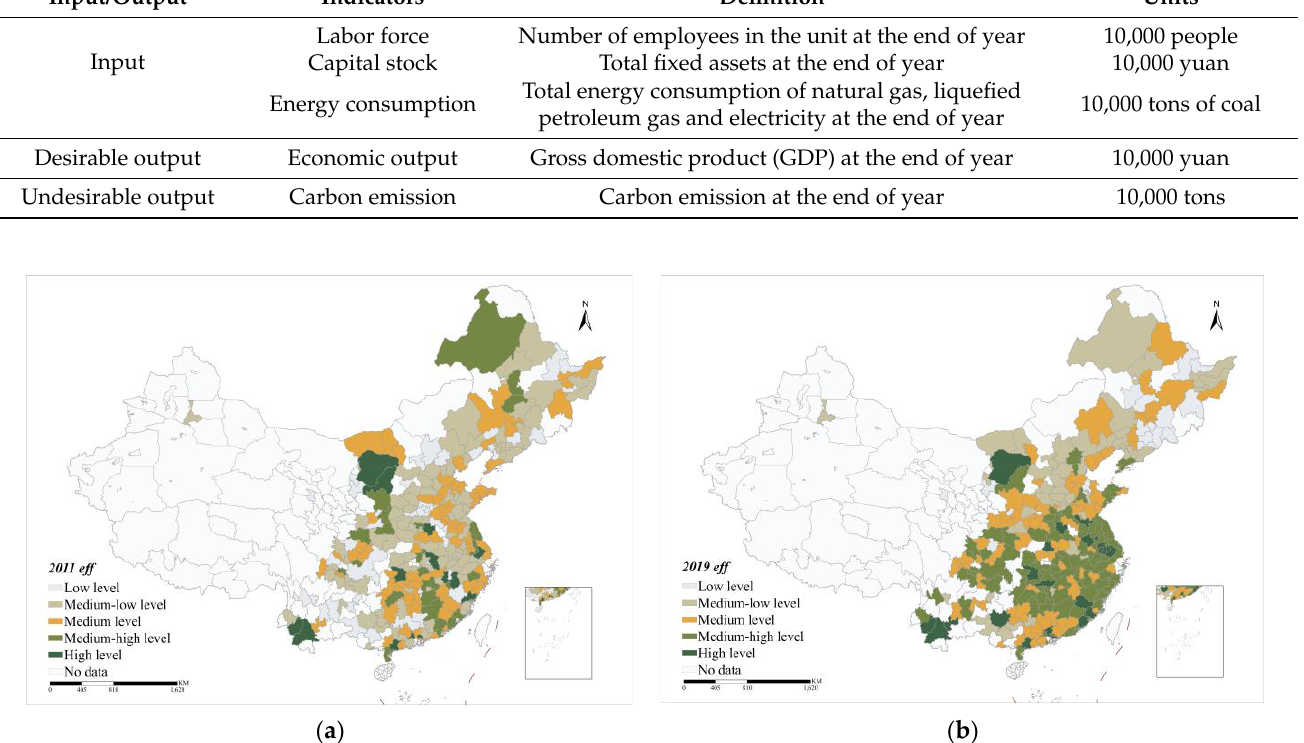
Figure 2. China’s carbon emission efficiency. ( a ) Spatial distribution in 2011; ( b ) Spatial distribution in 2019.